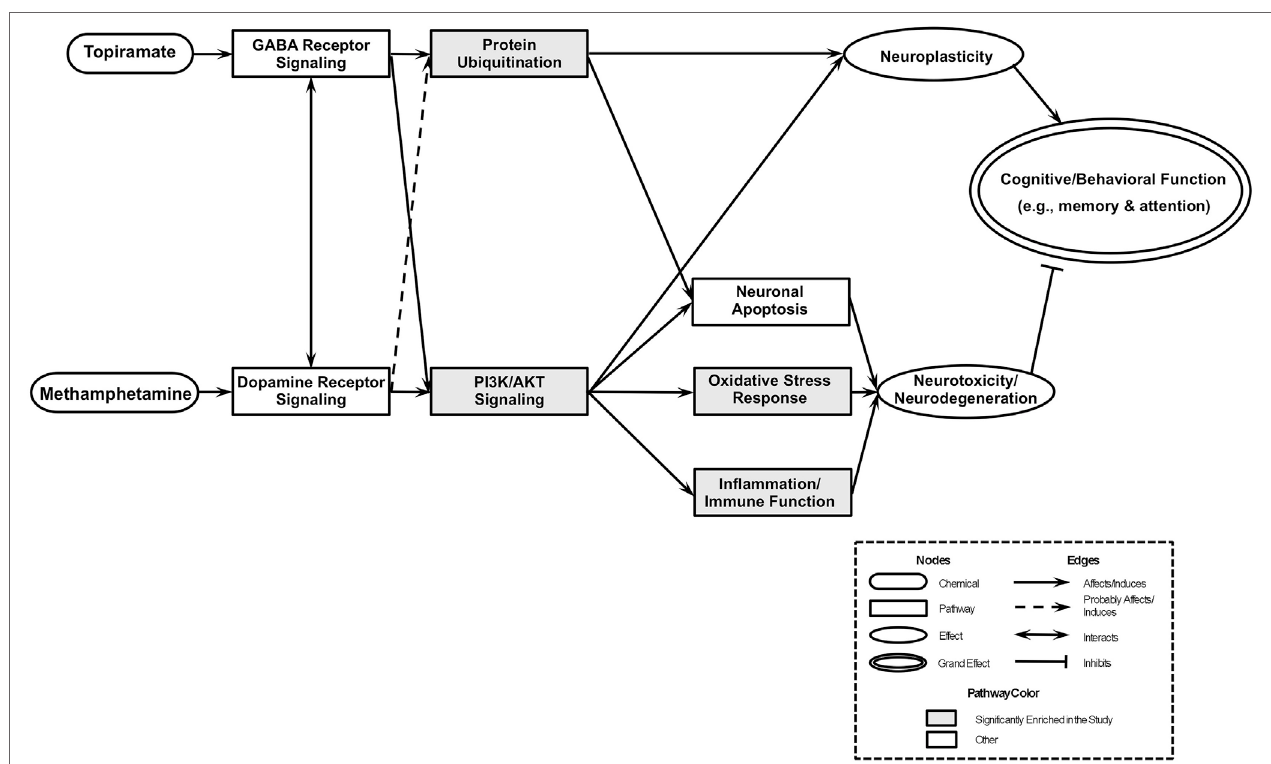
FigUre 4 | An integrated model of biological pathways related to topiramate (TPM) treatment for methamphetamine (METH) addiction. The joint effects of TPM and METH act on several molecular pathways that eventually lead to modulations of neuroplasticity and neurotoxicity/neurodegeneration, which results in abstinence and reduction of METH use. Pathways enriched exclusively in TPM responder groups at weeks 8 and 12 are highlighted in